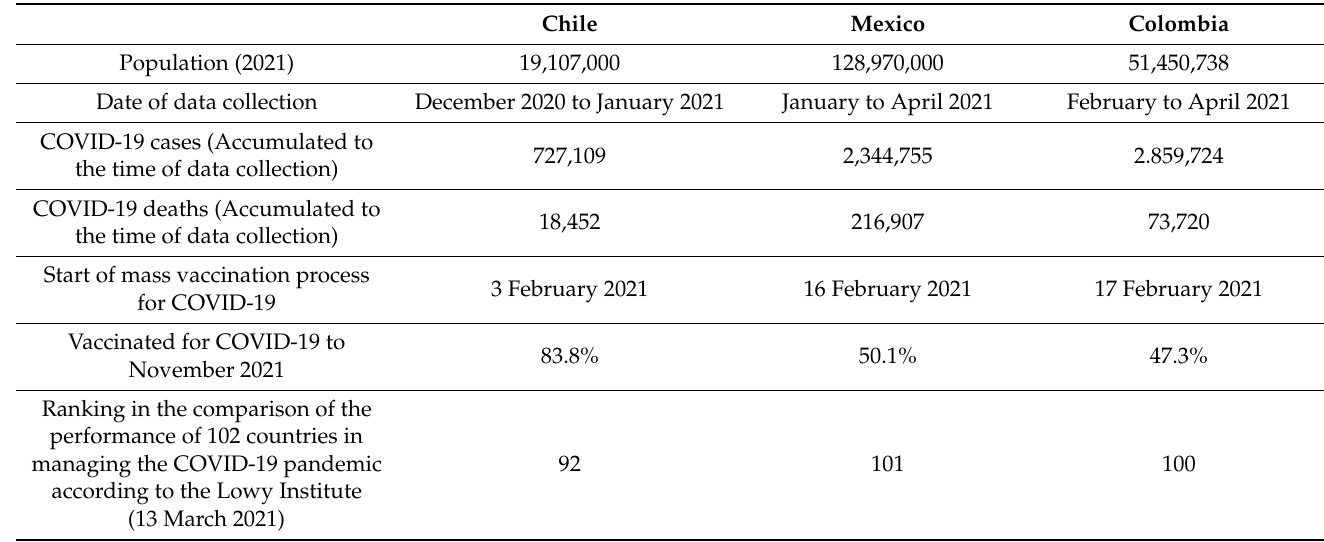
Table 1. ContextualinformationaboutCOVID-19andCOVID-19vaccinationinChile, Mexico, andColombia. Chile